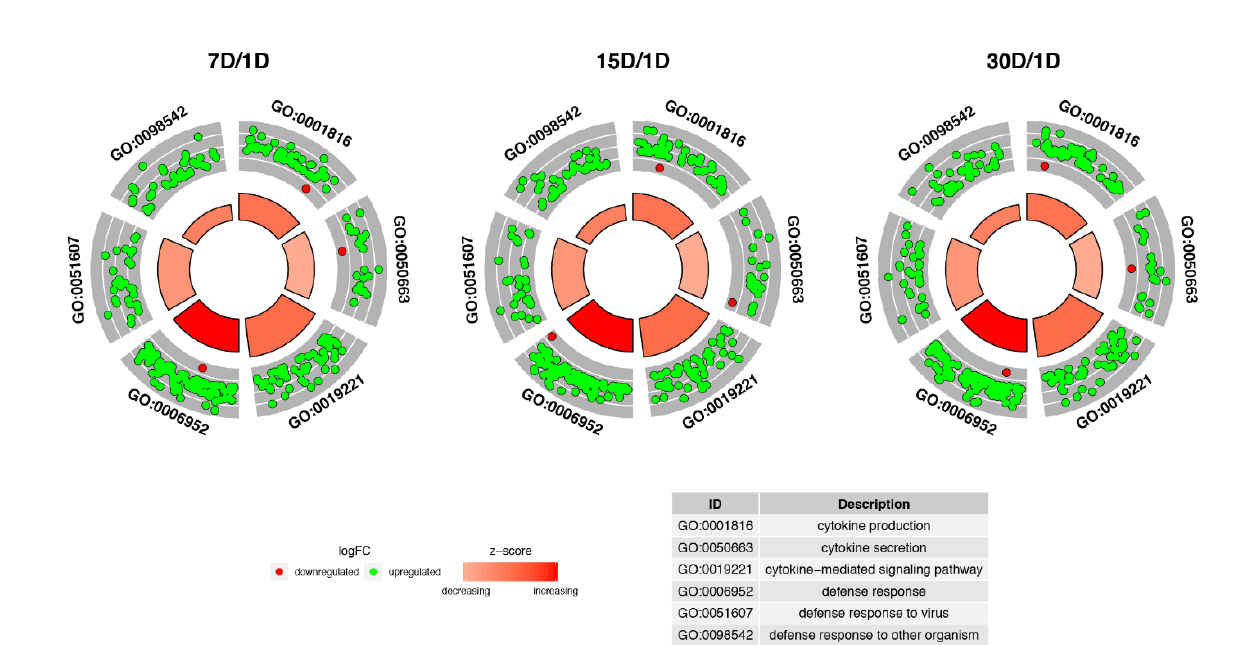
Figure 2. Circular scatterplots of the differentially expressed genes involved in “defense response to other organism”, “defense response”, “defense response to virus”, “cytokine secretion”, “cytokine production” and “cytokine-mediated signaling pathway” GO BP terms. Each dot represents a single gene. The z -scores are presented as segments of the inner circles.